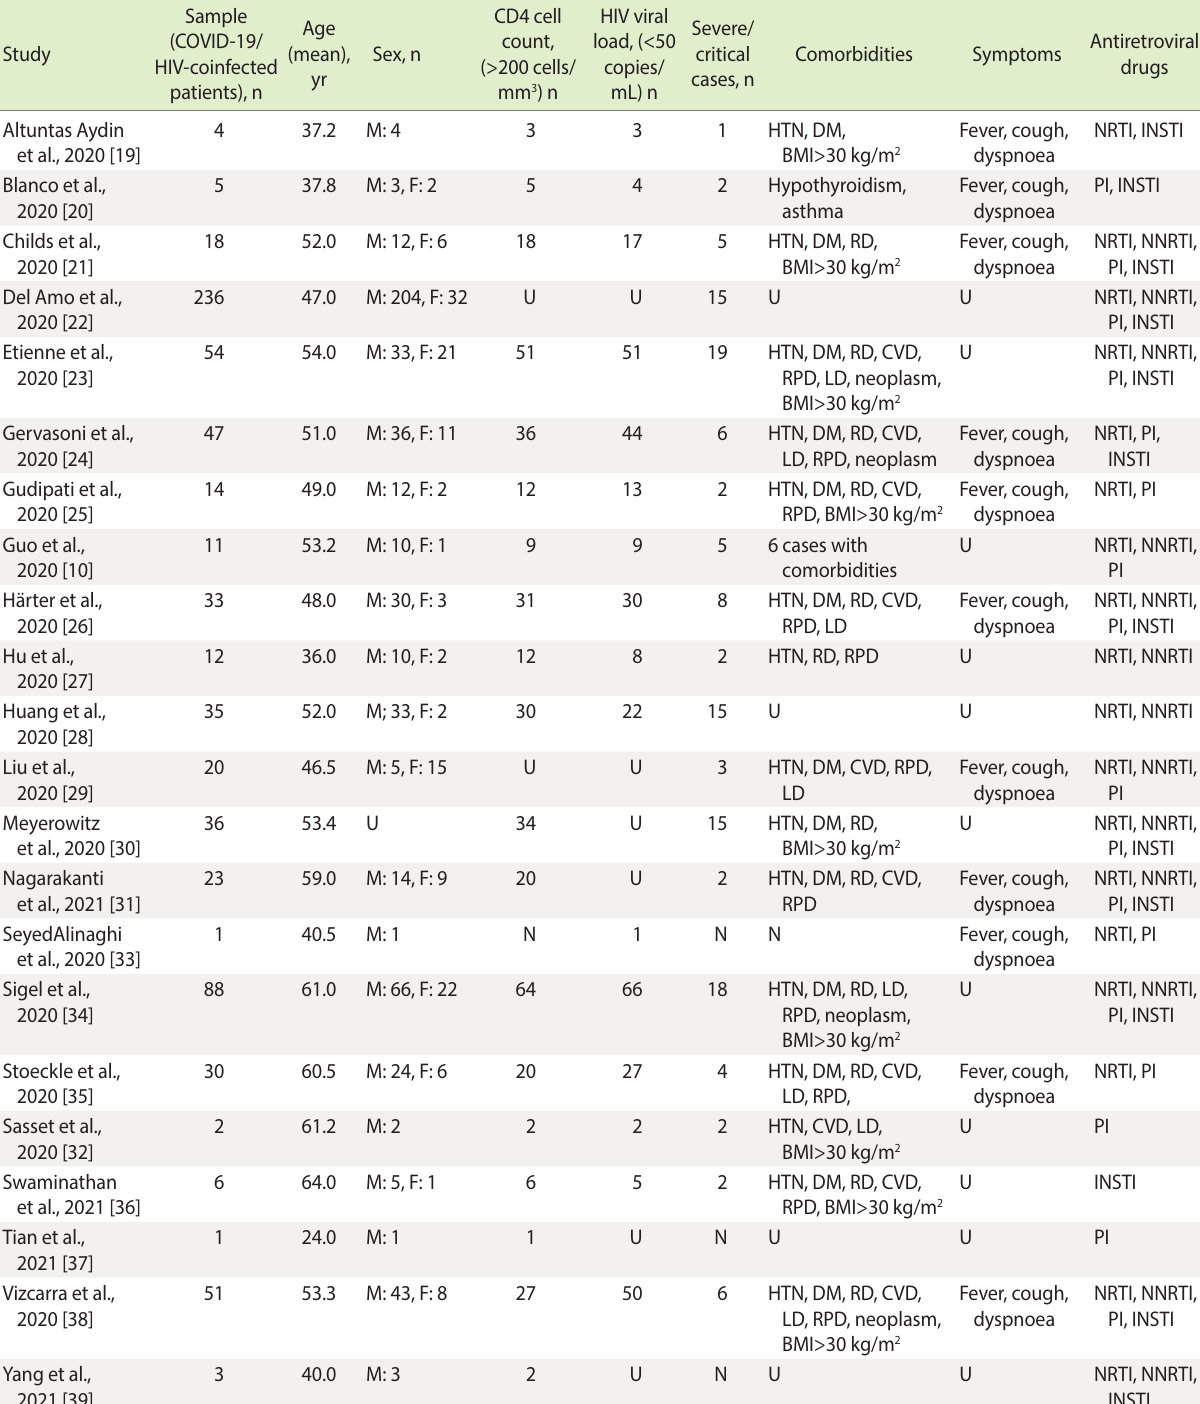
Table 3. Overview of the population characteristics from observational studies